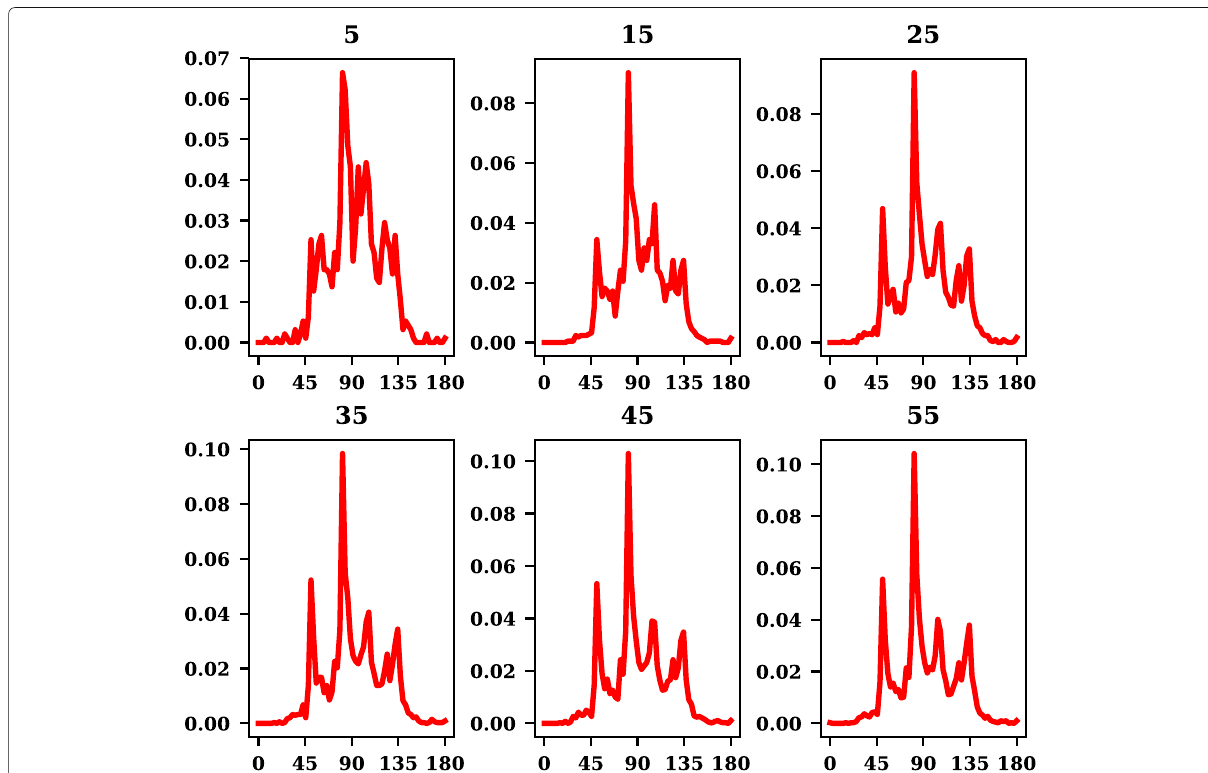
Fig. 6 Effect of dictionary size D T on SRP-NMF performance. Subplots show the histograms of SRP-NMF on a mixture of 4 sources taken from SiSEC database ( dev1_male4_liverec_250ms_5cm_mix.wav ) with β = 60 and D T varying from 5 to 55. D T is displayed on each of the subplots. The x -axis shows DoA (degrees). The y -axis is the (normalized) frequency of